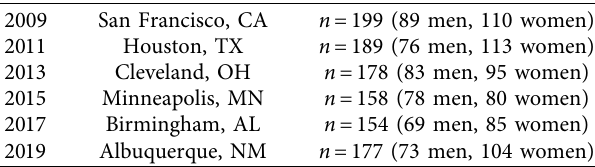
Table 1: NSGA biennial venues and 500-yard freestyle competitors.